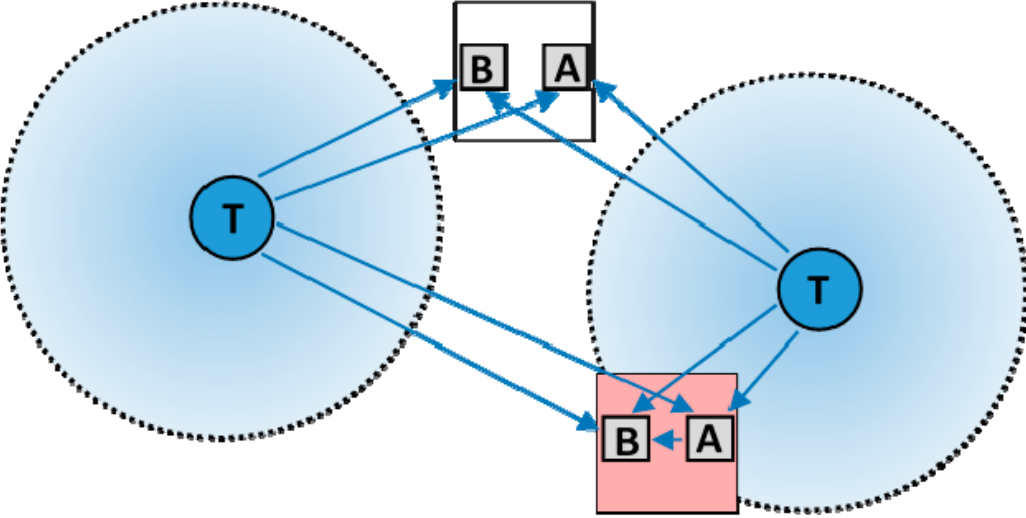
Figure 2. Plan view of basic structure of a system warning against approaching vehicles for workers using hearing protectors in the noisy work environment (T—transmitter mounted on a moving vehicle; A and B—pairs of wearable basic ( B ) receivers and additional ( A ) receivers/transmitters; blue arrows—Bluetooth connections; dashed circle—danger zone boundary defined by the selected received signal strength indicator (RSSI) value).